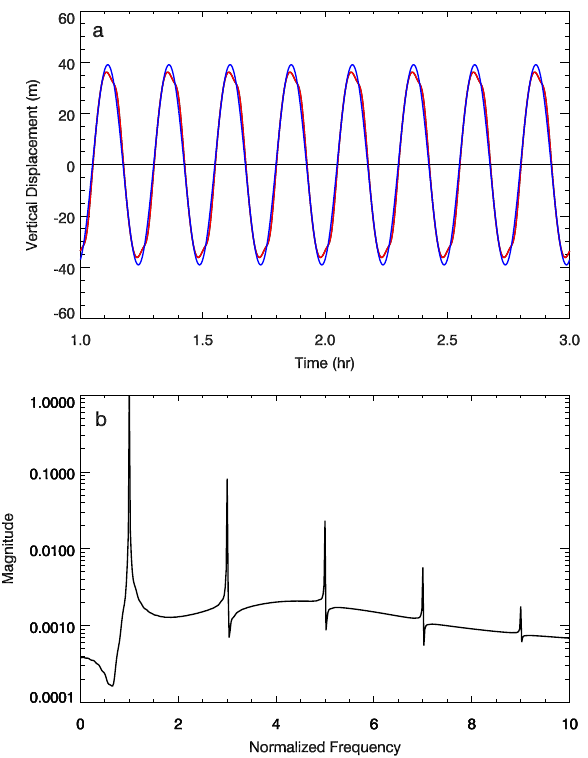
Fig. 1. (a) Vertical displacements of a 12m diameter superpressure balloon induced by a gravity wave with period 15min and vertical wind amplitude of 1ms − 1 . Results are plotted for the interval 1 to 3h after the simulation was turned on to avoid transient effects near t = 0. The red curve shows the numerical simulation while the blue curve shows results from the analytic method. (b) Normalized power spectrum of the numerically simulated SPB vertical displace- ments computed from the whole 12.5h duration of the time